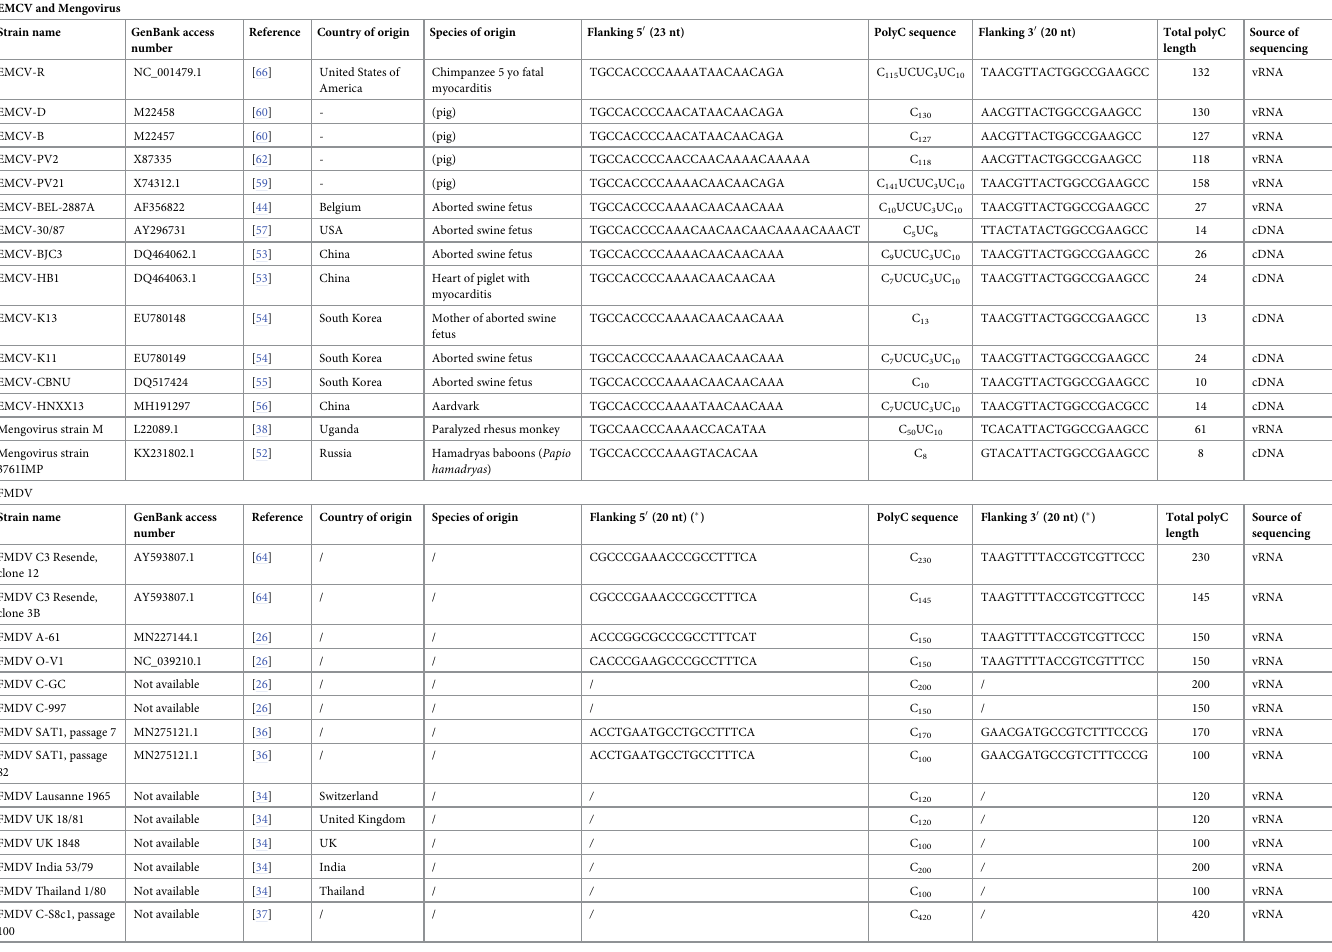
Table 1. Summary of polyC tract variants reported for Cardioviruses (EMCV and Mengovirus) and Aphthoviruses (FMDV) strains. EMCVandMengovirus Strainname GenBankaccess Reference Countryoforigin number